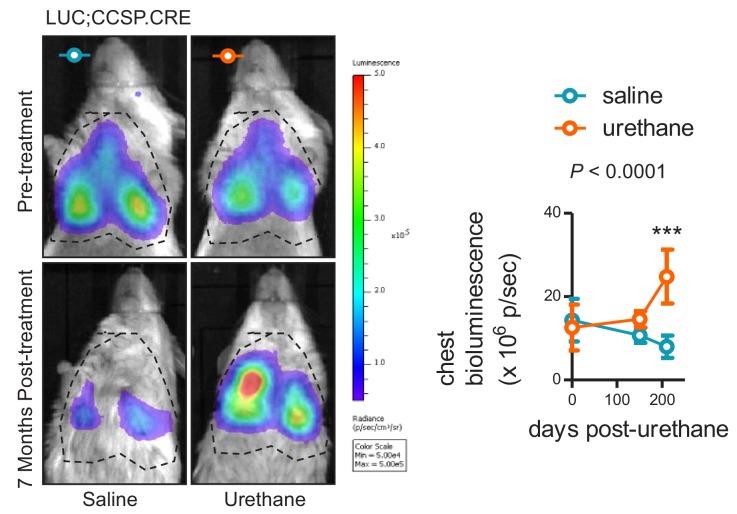
In vivo bioluminescent detection of the airway lineage in the lungs of saline- and carcinogen-treated mice.Representative merged bioluminescence/photographic images (left) and data summary (right) of LUC;CCSP.CRE mice (FVB background) before and seven months after saline (one intraperitoneal injection of 100 µL; n = 6) or urethane (one intraperitoneal injection of 1 g/Kg in 100 µL saline; n = 5) treatment. Note that in this model light is emitted exclusively by genetically CCSP-labeled cells over the lungs. Note also the signal decrease in saline- and increase in urethane-treated mice. Data are given as mean ± SD. P, overall probability, two-way ANOVA. ***: p<0.001 for comparison with saline, Bonferroni post-test.10.7554/eLife.45571.041Figure 3—figure supplement 5—source data 2.Quantification of chest bioluminescence signal in LUC;CCSP.CRE mice after urethane exposure.